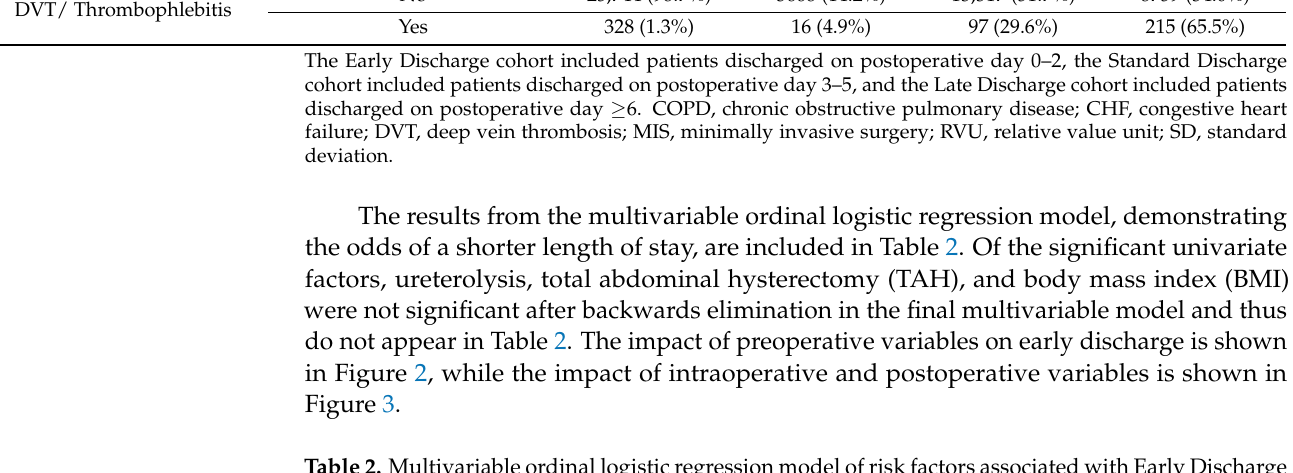
Table 2. Multivariable ordinal logistic regression model of risk factors associated with Early Discharge (POD